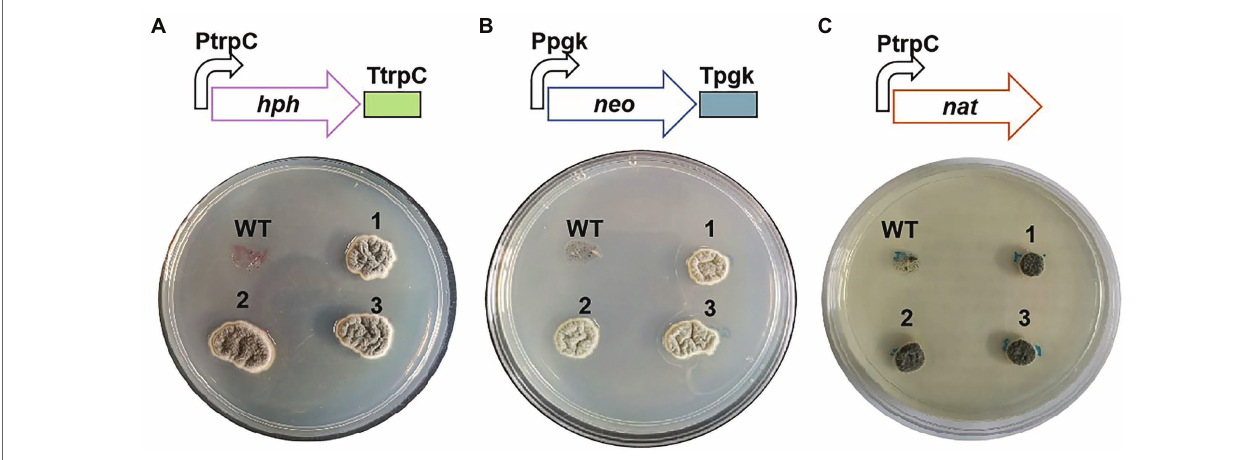
FIGURE 2 | Antibiotics sensitive tests of wild-type C. empetri MEFC009 and mutant strains. Mutant strains with resistance genes of hph (A) , neo (B) , and nat (C) . WT: C. empetri MEFC009, 1–3: mutant strains.